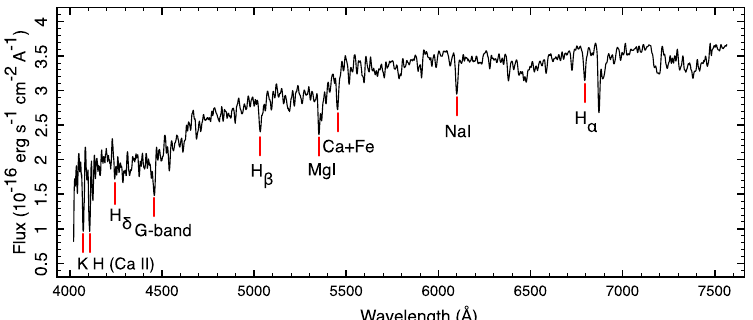
Figure 4. The smoothed spectrum of the galaxy IC 4765-f01-1504 from the Gemini South Telescope, with the most important absorption lines identified [19]. The drop at 6870 Å is due to the atmosphere OH absorption.